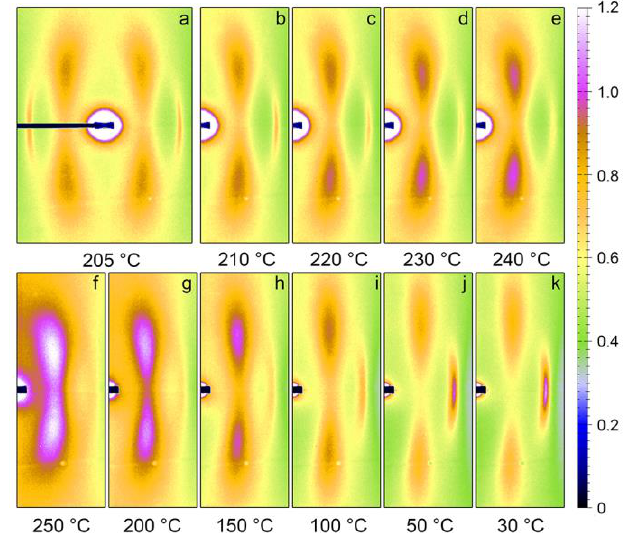
Figure 8. Low-angle XRD patterns of liquid crystal (LC) polymer 3 collected ( a − f ) on heating and ( g − k ) cooling the sample under a horizontal aligning magnetic field. Reprinted (adapted) with permission from [39]. Copyright 2014 American Chemical Society.